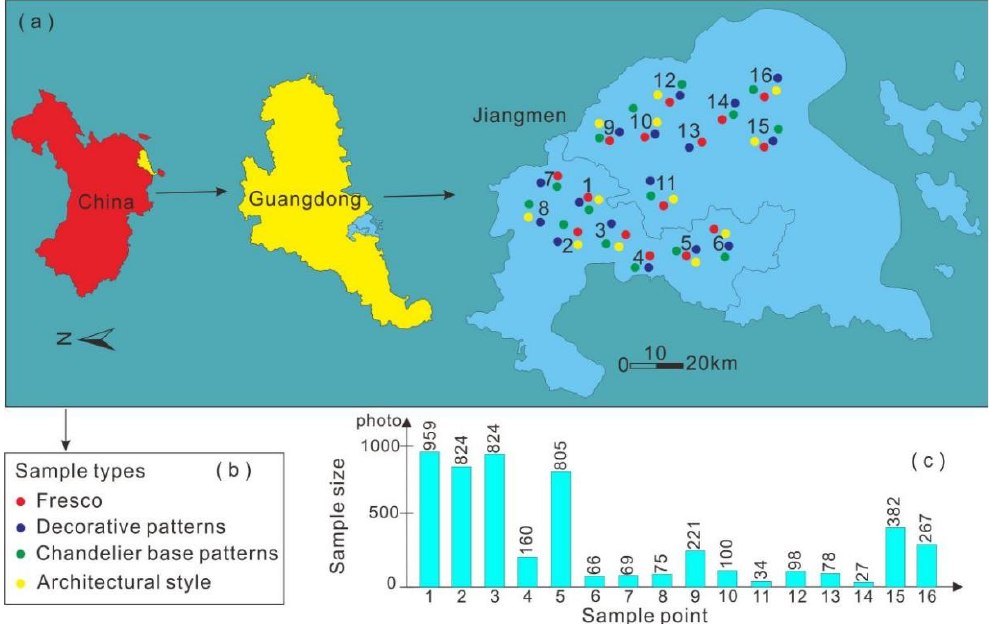
Figure 1. Sampling point map of the research area ( a ) geographical location; ( b ) sampling type; ( c ) number of samples.